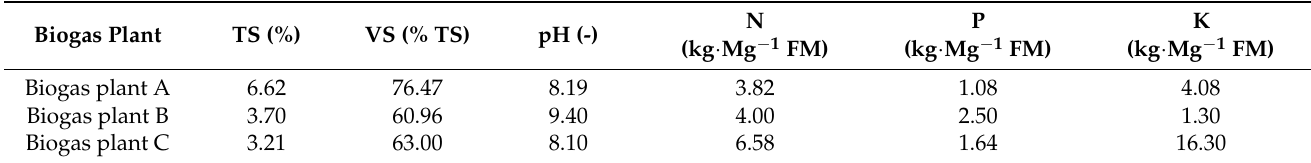
Table 1. Properties of the digestates generated at biogas plants